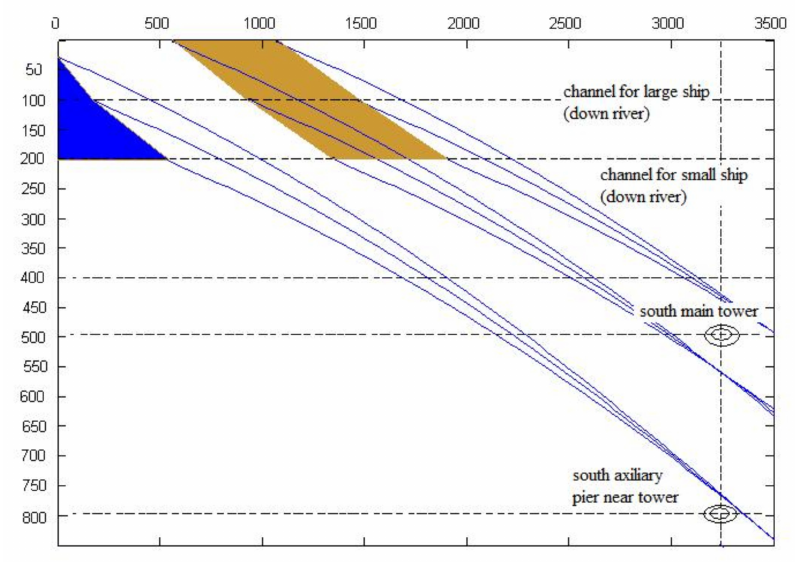
Figure 5. An example for dangerous areas in the drift model (based on